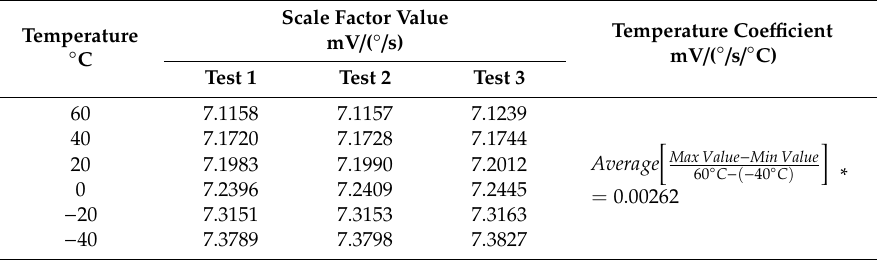
Table 2. MEMS gyroscope scale factor temperature coe ffi cient test